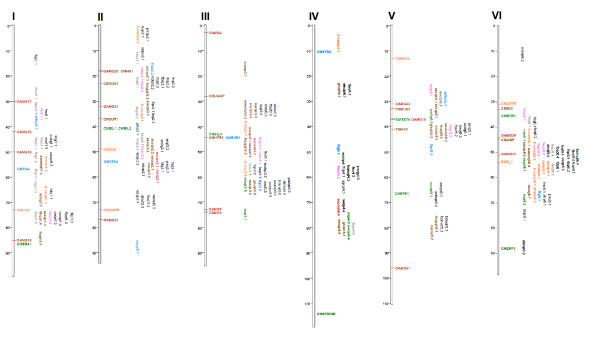
Quantitative Trait Loci (QTL) positioned in the melon integrated map. Linkage groups I to VI. QTL are located in a skeleton of the integrated map, where candidate genes for fruit ripening (green), flesh softening (blue), and carotenoid (orange), and sugar (brown) content are also shown. QTL are designated according to additional files 4 and 5 using the same colour code given for the candidate genes.